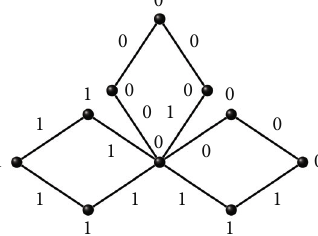
. Figure 2: Total edge product cordial labeling of C ð 3 Þ 7